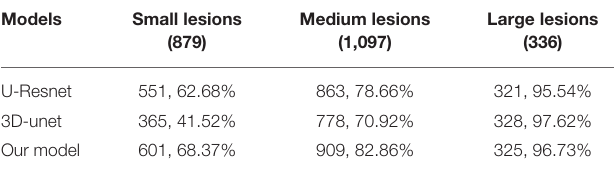
TABLE 3 | Models head-to head analysis (Data set 2)/Correct labled ratio.